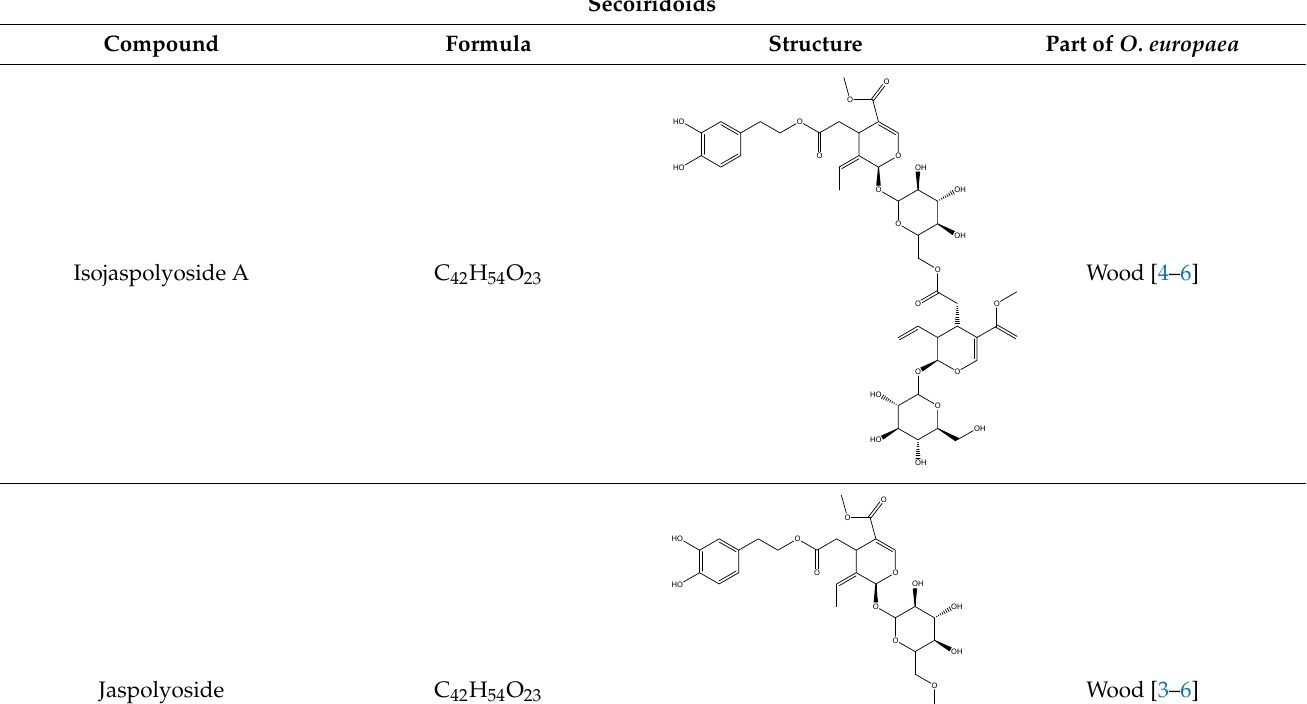
Table 1. Cont. Secoiridoids